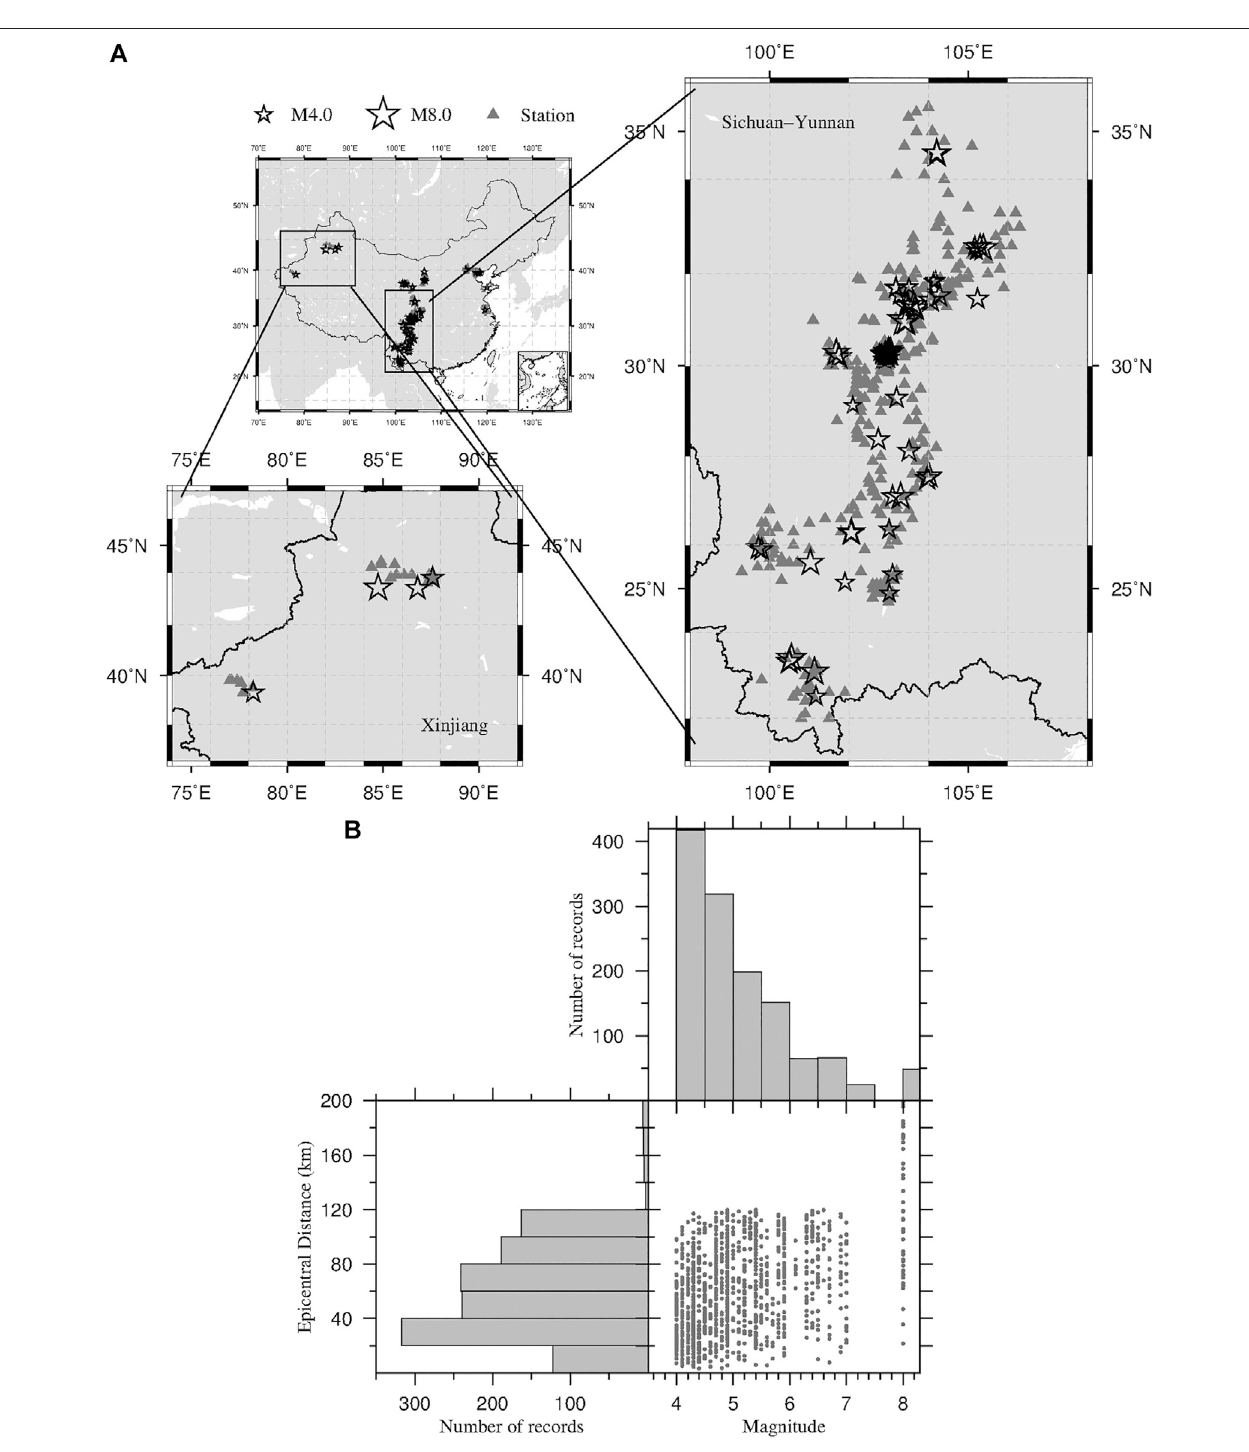
FIGURE 1 | Data distribution. Plot of (A) the epicentral position of the selected earthquakes and the location of stations and (B) the distribution of the analysed records as a function of the epicentral distance and magnitude.